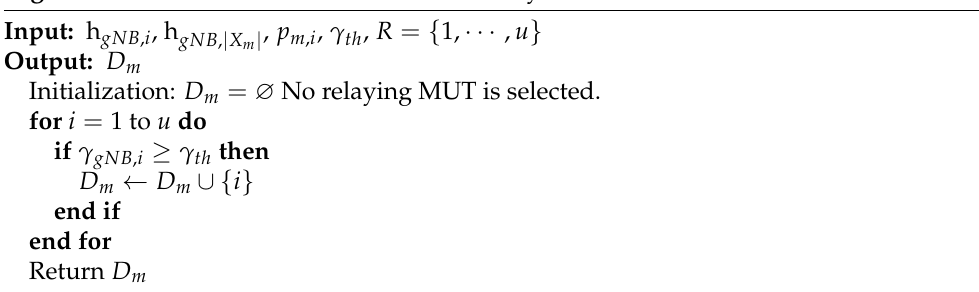
Algorithm 1 Threshold-based user-assisted relay